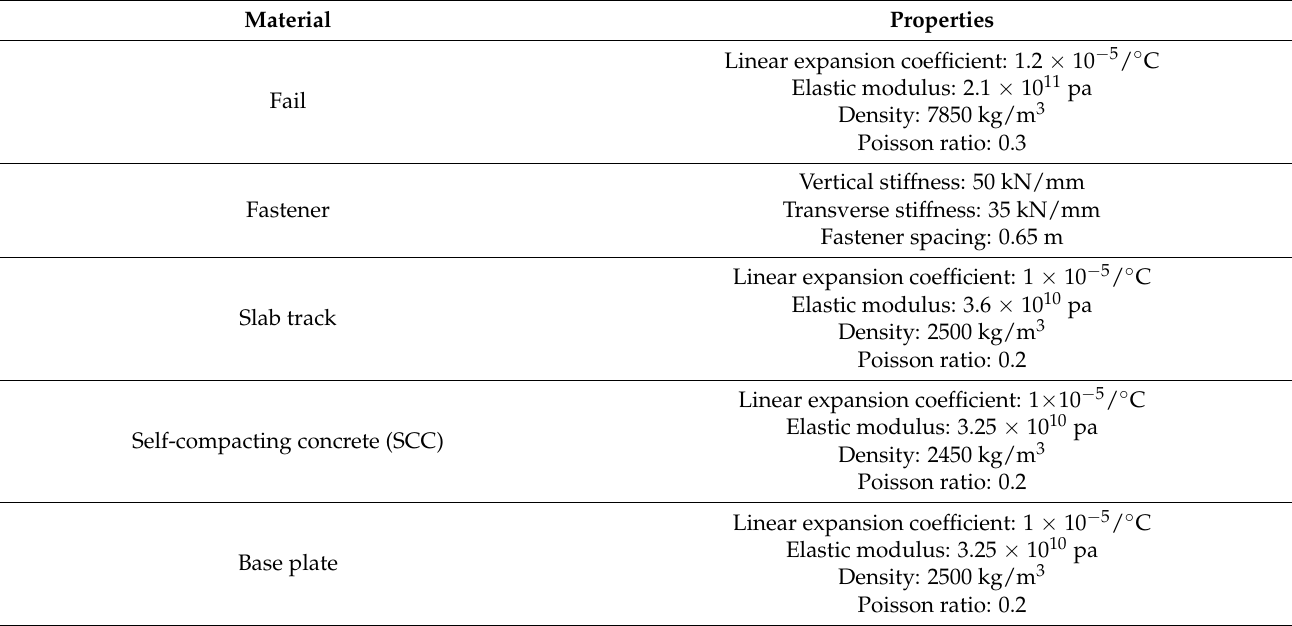
Table 3. Thermodynamic parameters of the ballastless track displacement simulation